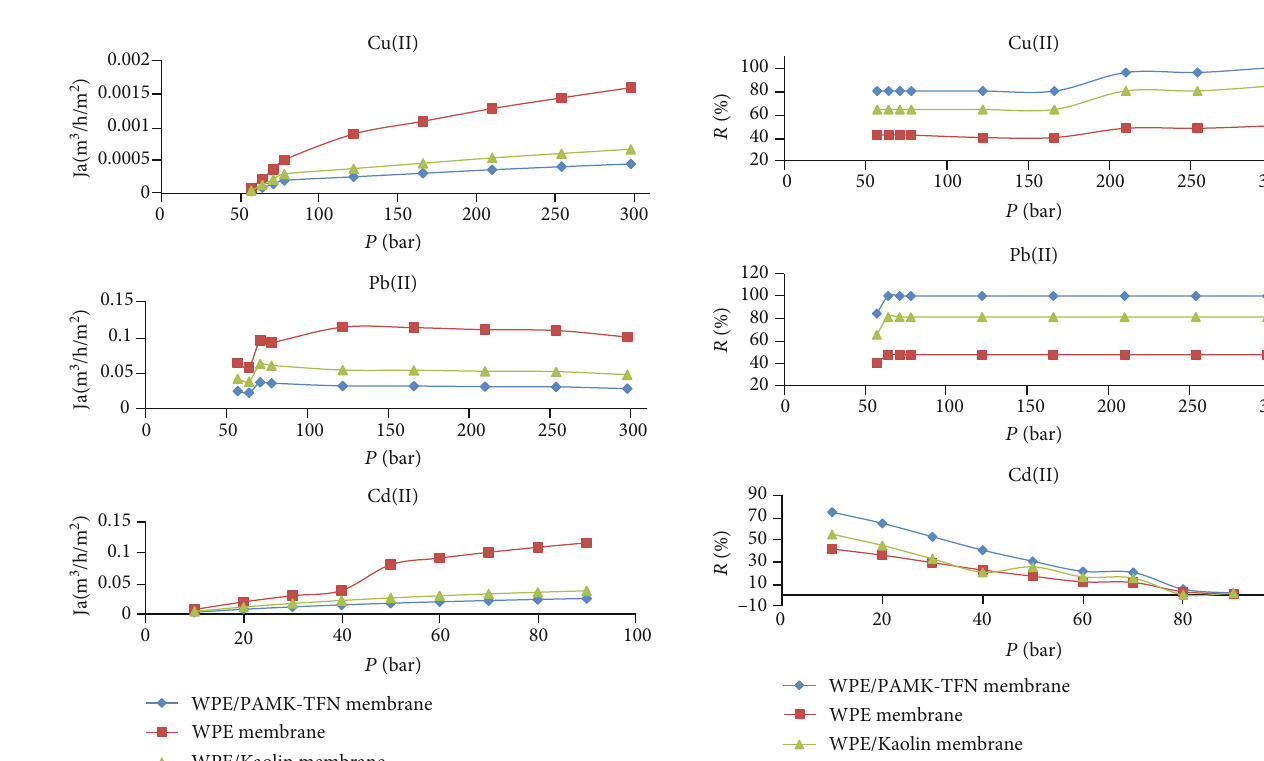
Figure 10: E ff ect of pressure on the heavy metals fi ltration on the fl ow rate of WPS, WPS/kaolin, and WPE/PAMK-TFN membrane.